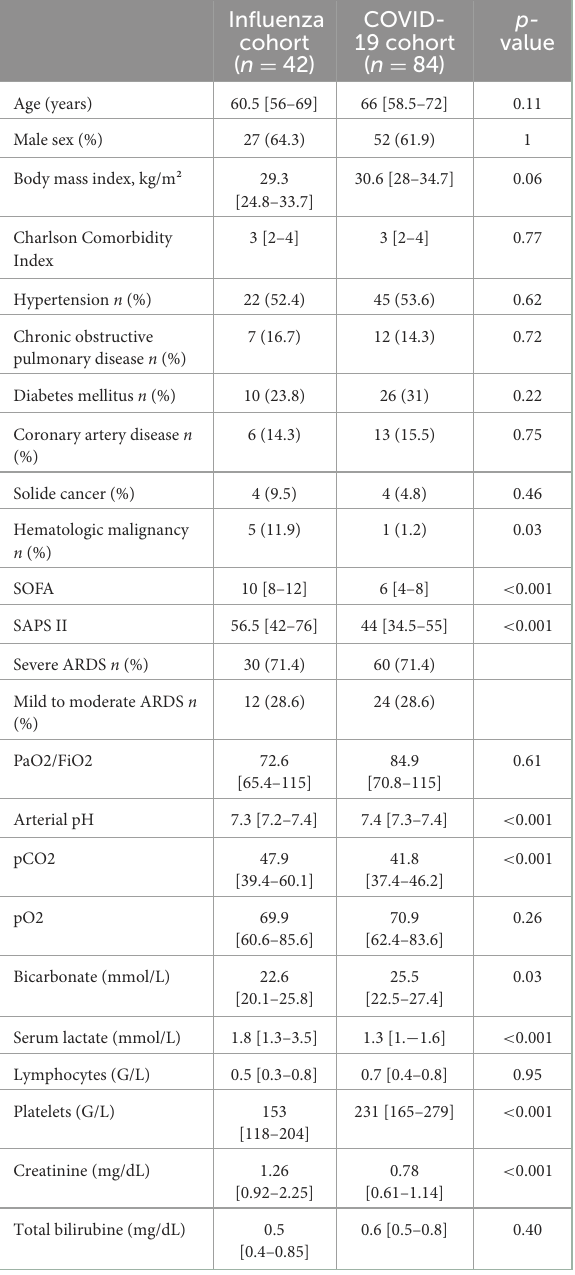
TABLE 1 Baseline